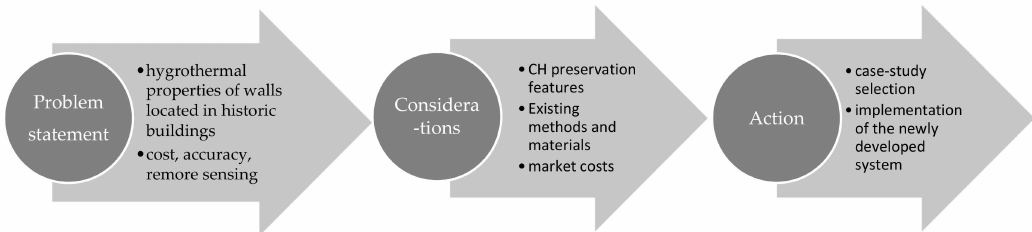
Figure 1. Description of the developed process for the definition and the installation of a cultural heritage (CH) compatible monitoring system (design by L. Dias